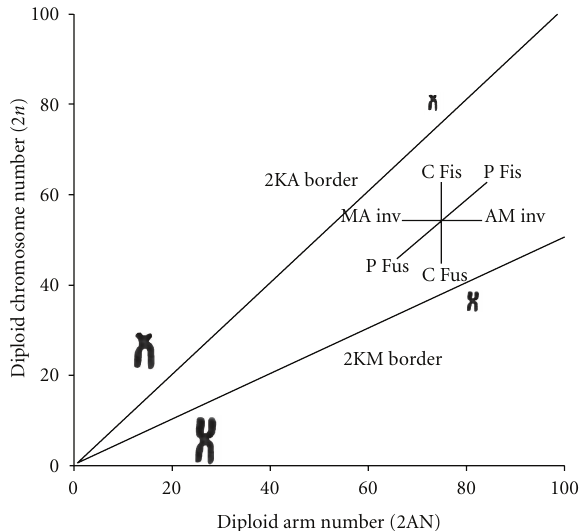
Figure 1: Karyograph adapted from Imai et al. [21] for ants. Since the genome is approximately constant for the whole Formicidae family, a proportional smaller chromosome size corresponds to the increase in the chromosome number. 2KA border: upper limit to the number of acrocentric chromosomes in diploid cells; 2KM border: lower limit to the number of metacentric chromosomes in diploid cells. C Fis: centric fission, C Fus: centric fusion, P Fis: pericentric fission, P Fus: pericentric fusion, AM inv: acrocentric-metacentric inversion, MA inv: metacentric-acrocentric inversion.